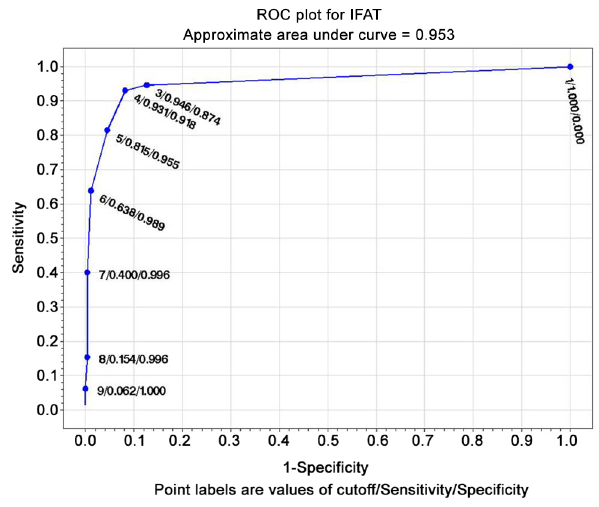
Figure 4. ROC curve for IFAT (composite reference standard) (numbers correspond to titers, 3=1/20 to 9=1/1280).